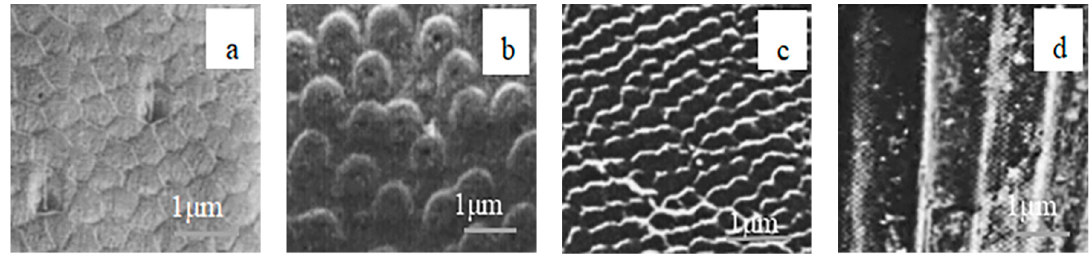
Figure 3. Non-smooth texture. ( a ) Pit; ( b ) convex hull; ( c ) corrugation; and ( d ) groove.